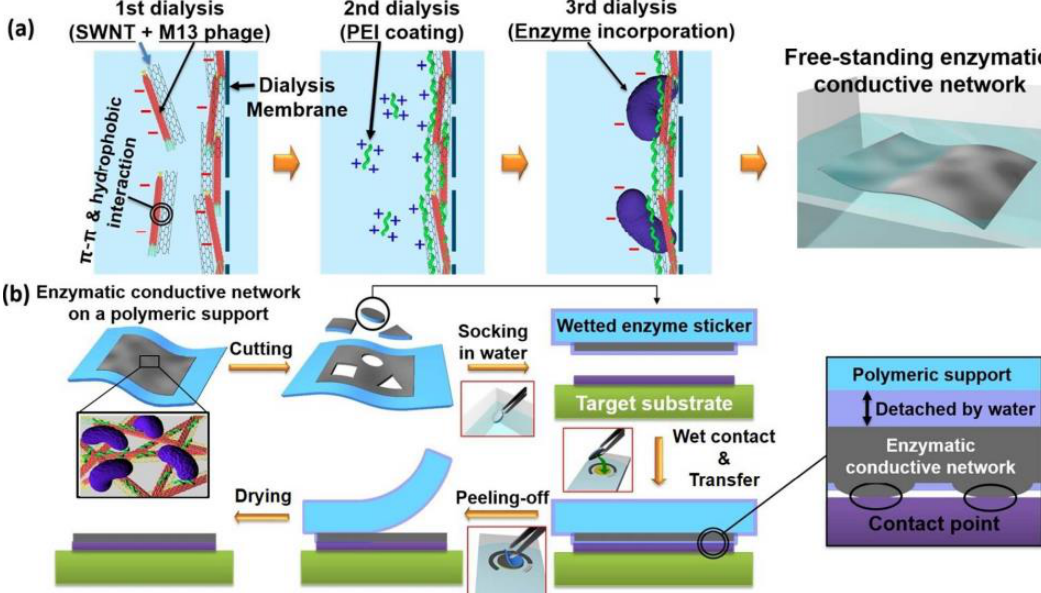
Figure 10. ( a ) Illustration of hydrodynamic layer-by-layer assembly of enzymatic conductive nano-networks. ( b ) Structure of an enzyme sticker and principles exploited for the contact-printing of an enzymatic network film. Reprinted with permission from [89]. Copyright (2018) American Chemical Society.